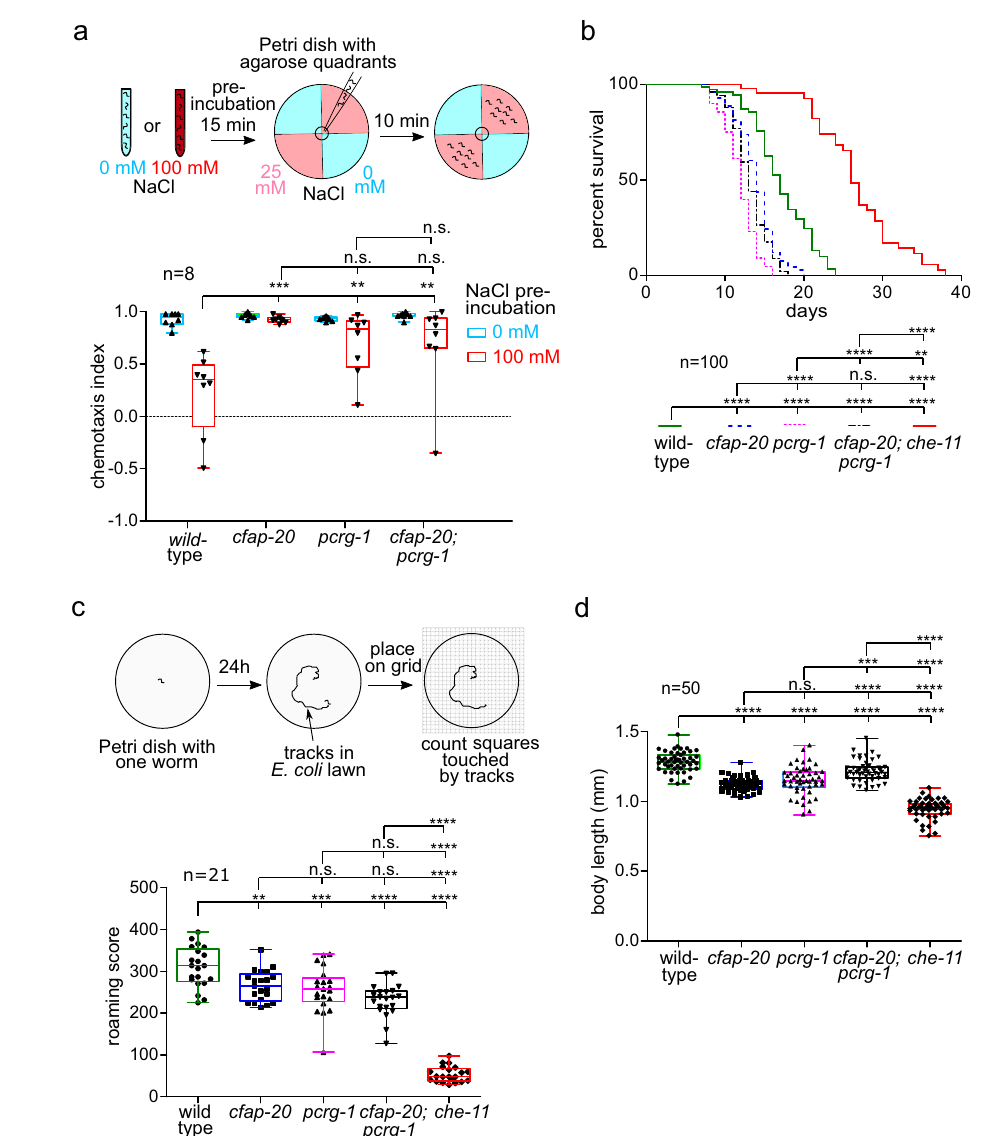
Fig. 4 | C. elegans CFAP20 and PACRG perform non-redundant roles in cilium- dependent behaviours and development: gustatory plasticity, lifespan con- trol,locomotion,andbodysize.a C.eleganscfap-20 and pcrg-1 singleanddouble mutants show defects in gustatory plasticity. Wild-type animals pre-exposed to a high NaCl concentration (100mM) display a reduced attraction to NaCl in che- motaxisassaysinvolving0mMand25mMNaClquadrantplates.Afterexposureto high-NaCl conditions, cfap-20 and pcrg-1 single and double mutants still have sig- ni fi cantlyincreasedattractiontoNaClcomparedtowild-type(one-wayANOVAand Bonferronitest P values:WTvscfap-20=0.005;WTvs.pcrg-1=0.0001;WTvscfap- 20;pcrg-1=0.006; cfap-20 vs pcrg-1=0.9999; cfap-20 vs cfap-20;pcrg-1=0.9999; pcrg-1vscfap-20;pcrg-1=0.9318). b C.eleganscfap-20 and pcrg-1 singleanddouble